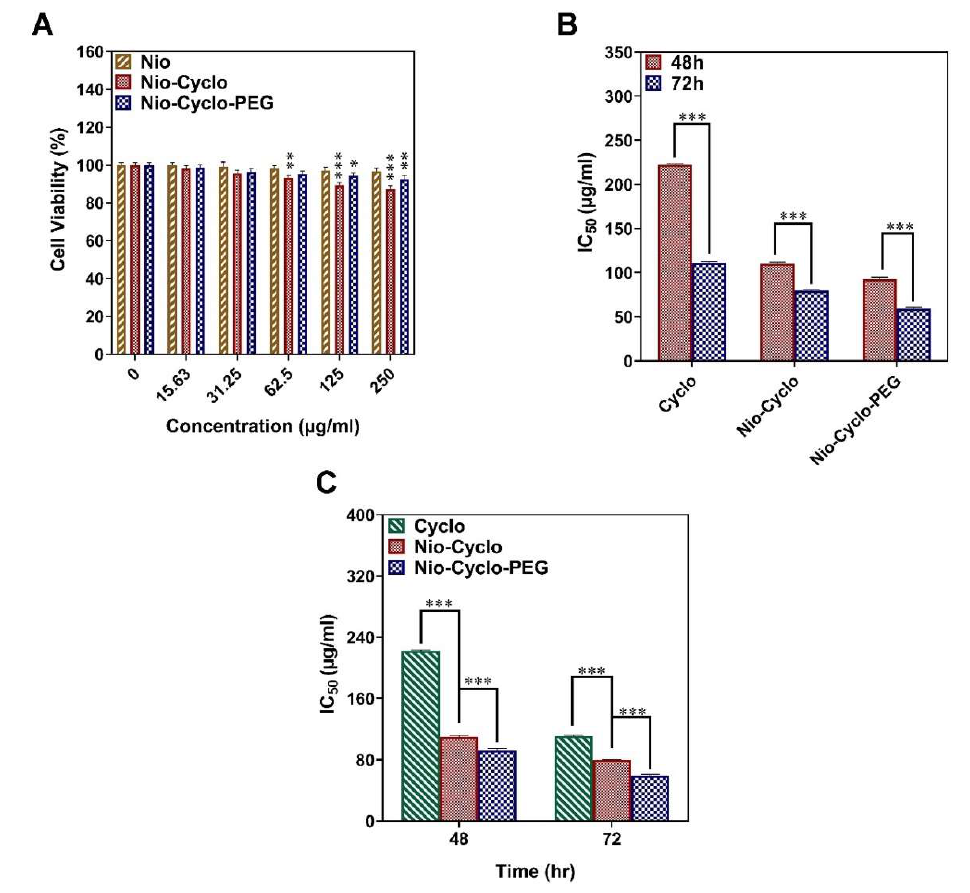
Figure 4. ( A ) Cell viability after treating the HFF cells with different concentrations of niosomal formulations. ( B ) The effect of time on IC 50 for each sample against AGS cells. ( C ) Comparison of IC 50 in groups at 48 and 72 h tested on the AGS cells. Data are represented as Mean ± SD from three independent experiments (*: p < 0.05, **: p < 0.01 and ***: p < 0.001).